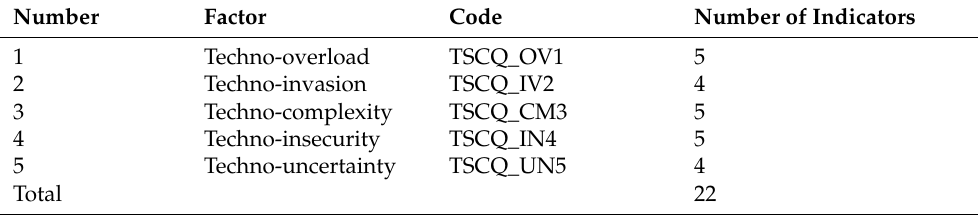
Table 1. The subfactors of the TSC-Q scale, and corresponding number of items.